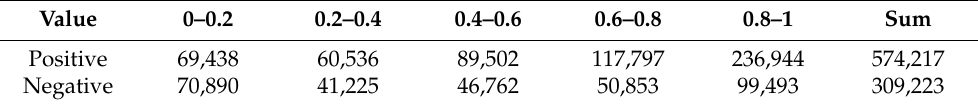
Table 6. Intensity distribution of emotion scores.